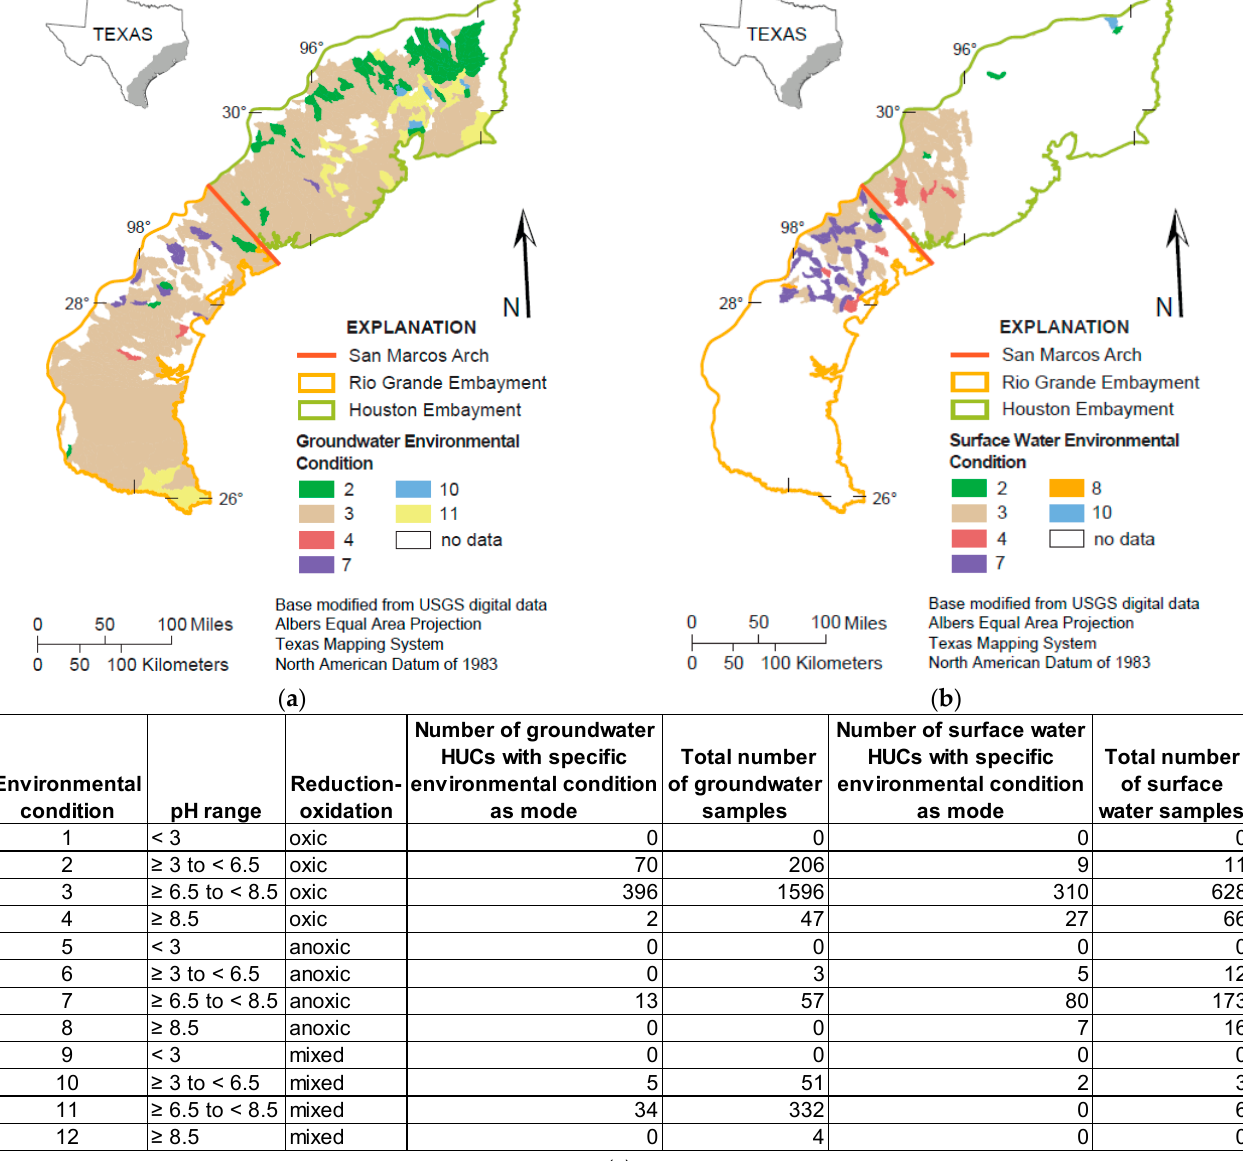
Figure 5. Spatial plots of the mode of the environmental conditions by hydrologic unit code (HUC) reported in ( a ) NURE groundwater data and ( b ) NURE surface water data. ( c ) Distribution of environmental conditions from Blake et al., 2022 [7].